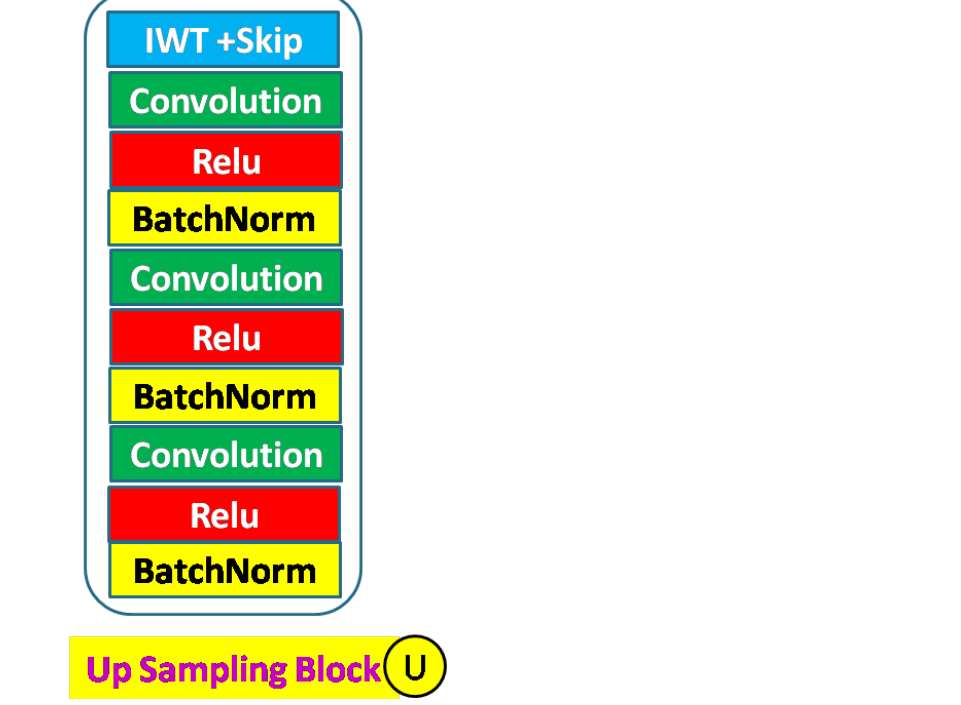
Figure 7. Up–sampling block details: The stack of convolution operators and the sequence of Batch–Norm and activation layers are customized. The convolution stack can be replaced with a residual block.